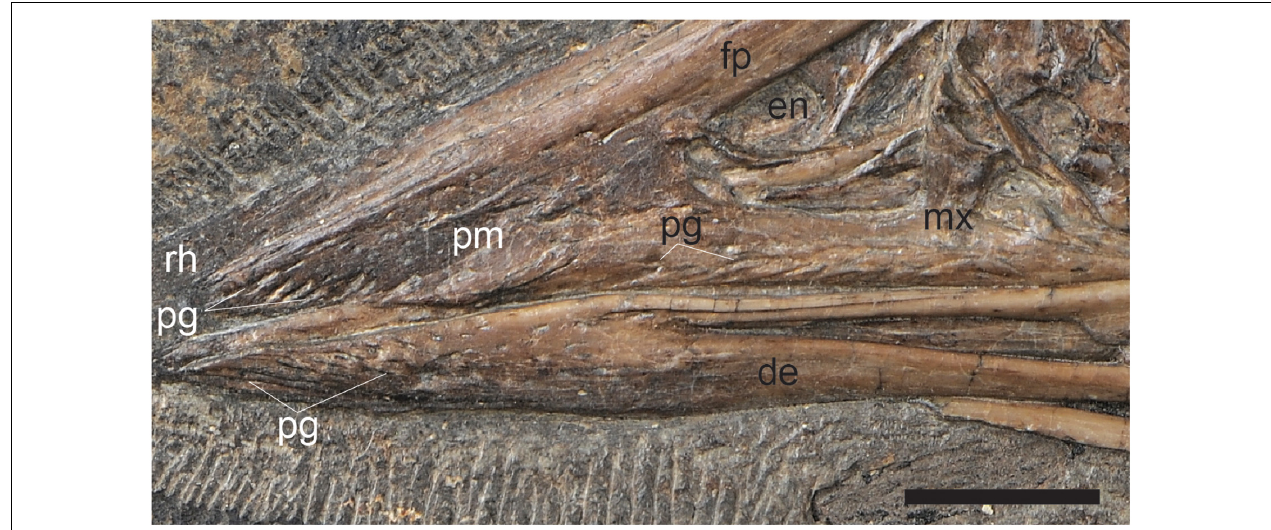
FIGURE 6 | A close up of the cranial half of the rostrum in C. sanctus IVPP V12352 showing the pits and grooves that cover the premaxillary body, premaxillary process of the maxilla, and the rostral portion of the dentaries, inferred to reflect neurovasculature related to the presence of a keratinous beak. Scale bar equals five millimeters. Anatomical abbreviations not listed in Figure 3 caption: pg, pits and